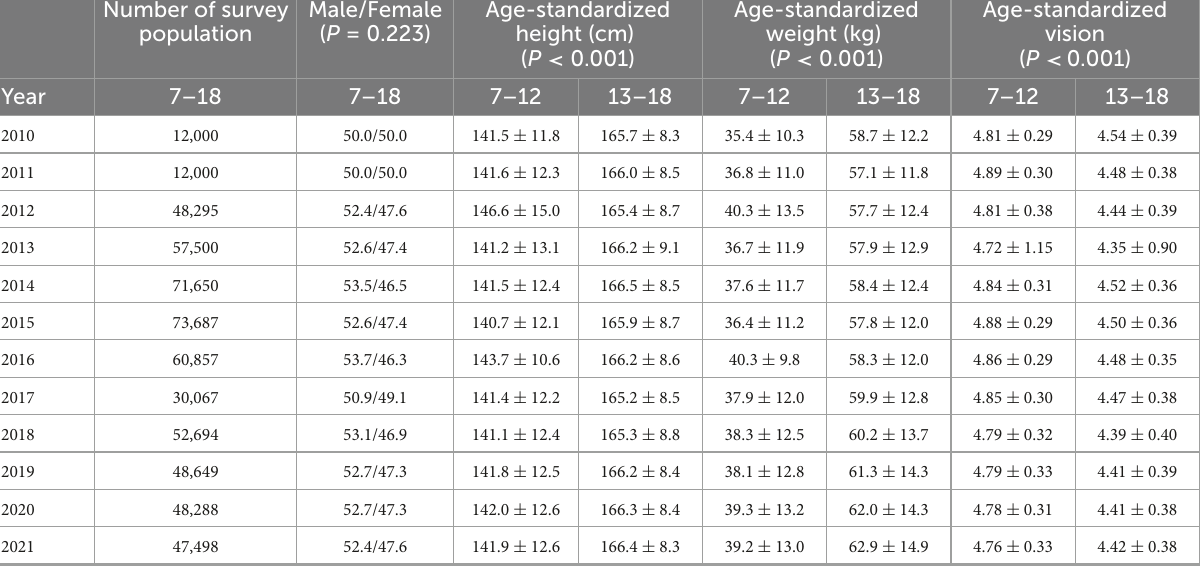
TABLE 1 The demographic characteristics of the study participants from 2010 to 2021 aged 7–18 years. Number of survey